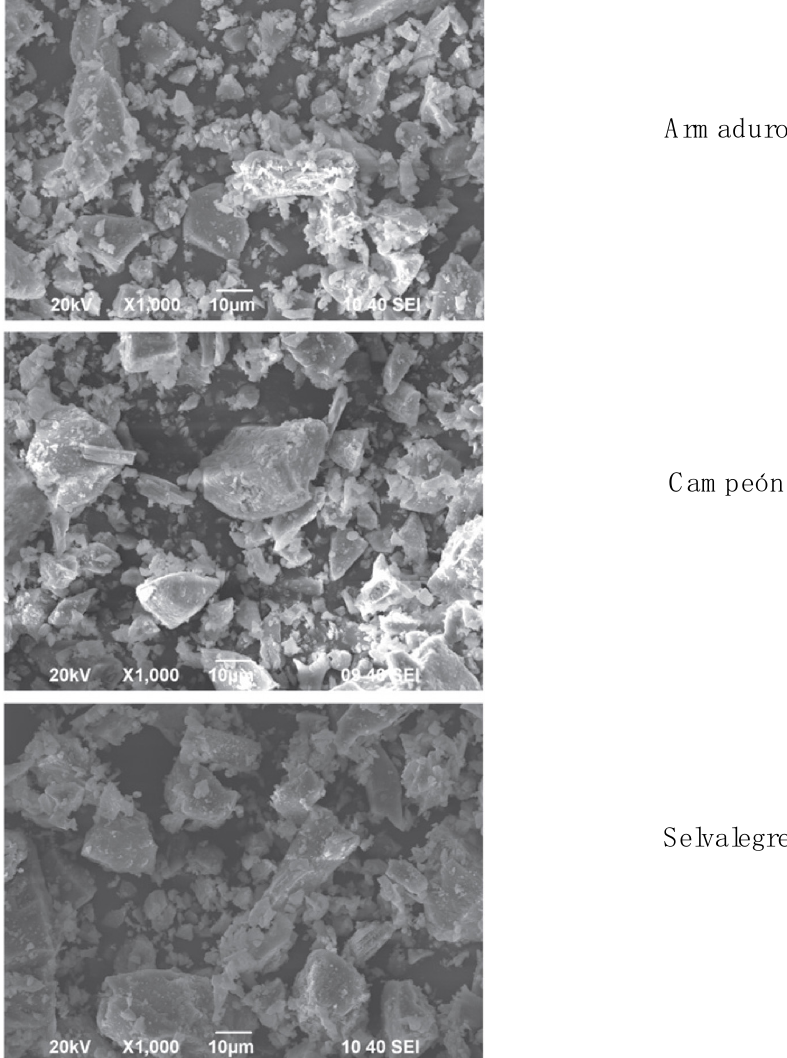
Figure 3. Normalized size distribution of the three sands.